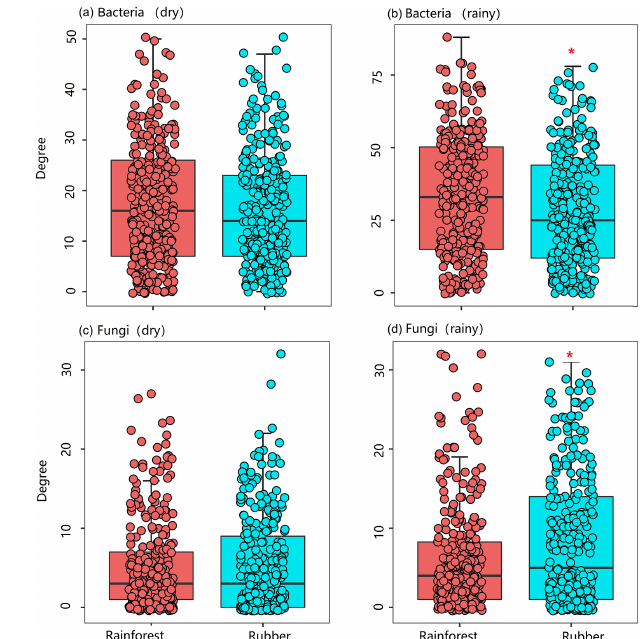
Figure 5. The network degree of soil bacterial and fungal commu- nities of rubber plantations (blue) and tropical rainforests (red) in the dry and rainy